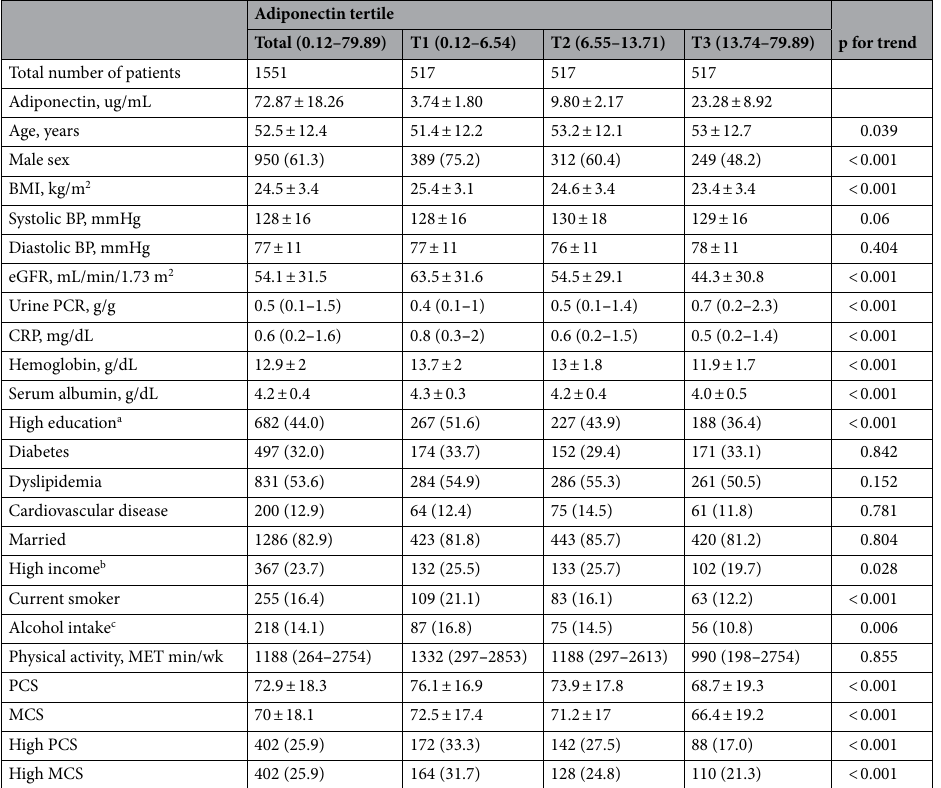
Table 1. Baseline characteristic of participants according to serum adiponectin tertile. Values for categorical variables are reported as number (percentage) and for continuous variables as mean ± standard deviation or median (interquartile range). The p values are for the Kruskal–Wallis tests or one-way analysis of variance for continuous variables and Chi-square tests for categorical variables. PCS physical component summary;